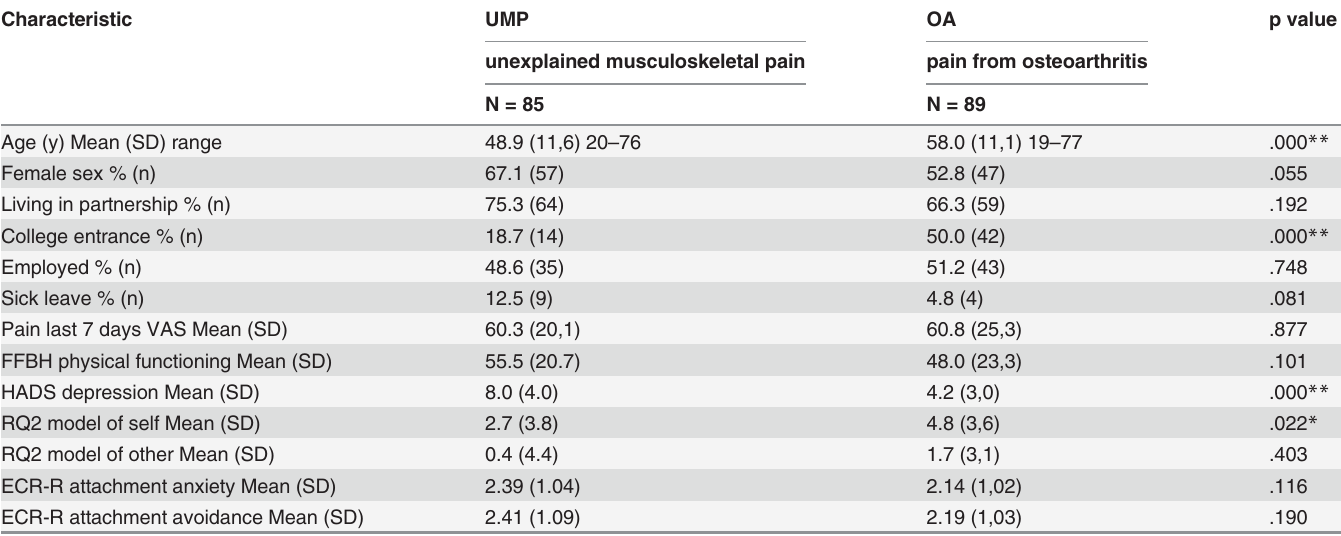
Table 1. Demographic and clinical